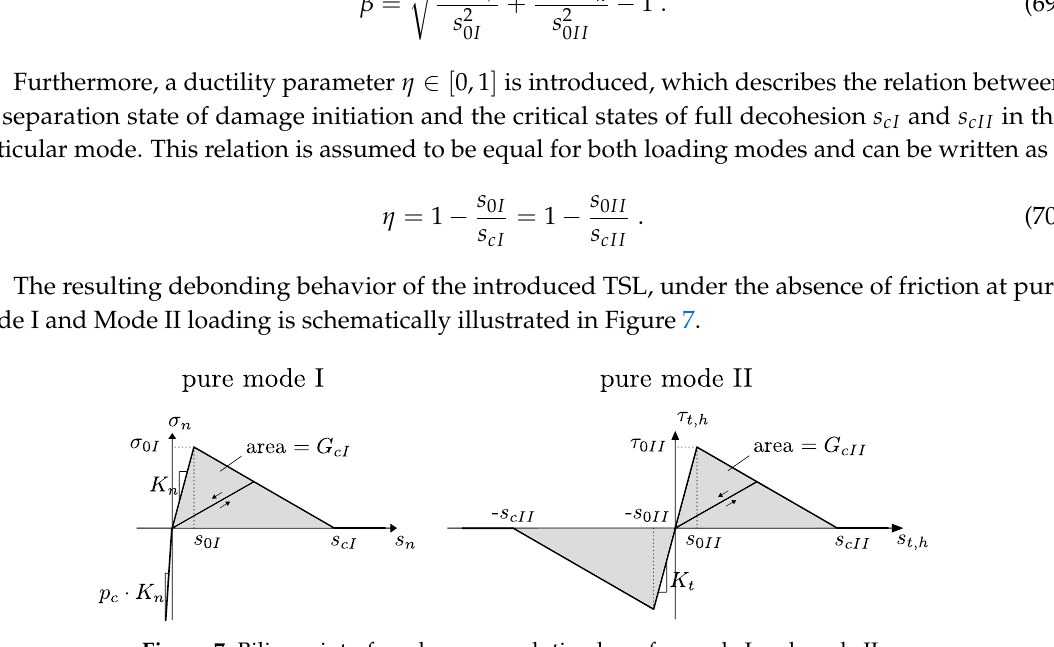
Figure 7. Bilinear interface damage evolution laws for mode I and mode